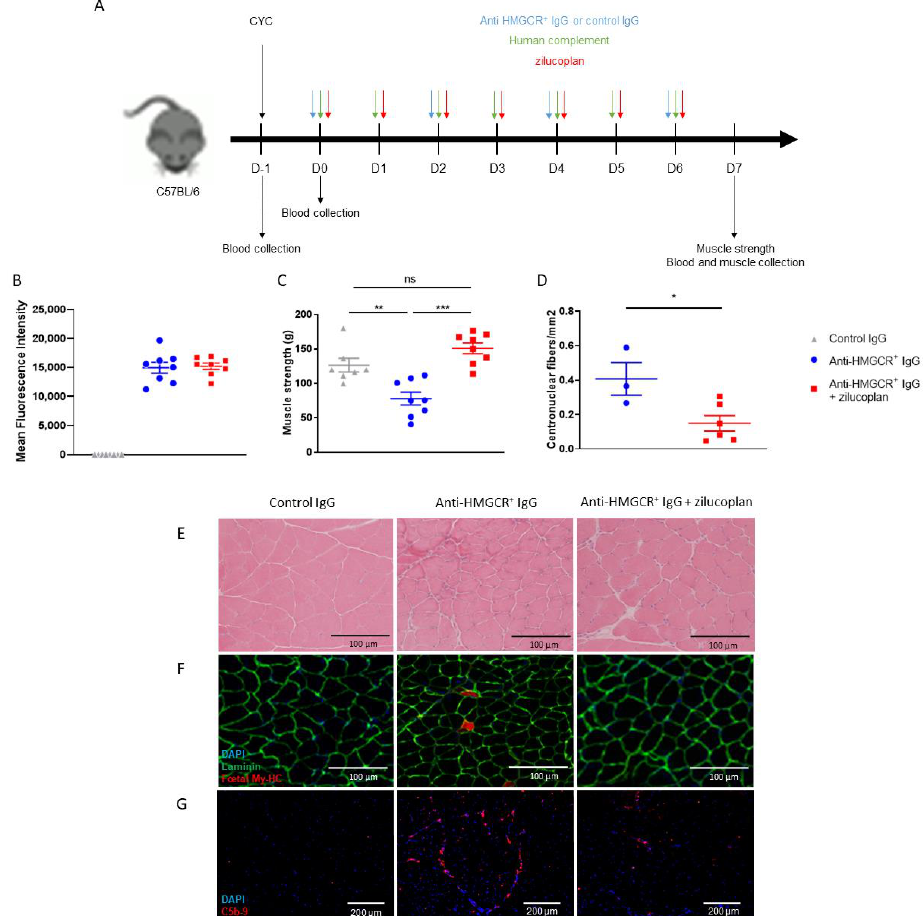
Figure 2. C5 inhibition prevents the development of IMNM in C57BL/6 mice supplemented with human complement. ( A ) C57BL/6 mice (n = 8/group) were transiently immunosuppressed by a single injection of cyclophosphamide (CYC) and received injections of purified IgG from a patient suf- fering from anti-HMGCR + IMNM with or without zilucoplan in conjunction with human comple- ment. Control is IgG from normal serum in conjunction with human complement. ( B ) Circulating levels of anti-HMGCR aAb by addressable laser beads immunoassay (ALBIA) in the serum of mice at day 7. ( C ) Muscle strength was evaluated by measurement of gastrocnemius contraction upon electrostimulation (muscle strength). ( D ) Quantification of regenerative muscle fibres in all assess- able frozen tibialis muscle biopsies from mice injected with control IgG or anti-HMGCR + IgG with or without zilucoplan. ( E ) H & E staining. Scale bar = 100 µm. ( F ) Immunodetection of regenerative myofibres after staining with mouse anti-foetal myosin heavy chain (My-HC) antibody followed by Alexa 647-labeled anti-mouse IgG antibody (red). Muscle fibres are made visible using rabbit anti- laminin antibody followed by Alexa 488-labeled anti-rabbit IgG (green) and DAPI (blue) for staining nuclei. Scale bar = 100 µm. ( G ) Complement deposits (red) on the surface of myofibres after staining with rabbit anti-C5b-9 antibody followed by Alexa 647-labeled anti-rabbit IgG and DAPI counter- staining (blue). Scale bar = 200 µm. Data are presented as mean ± SD; ns is for non-significant * p <